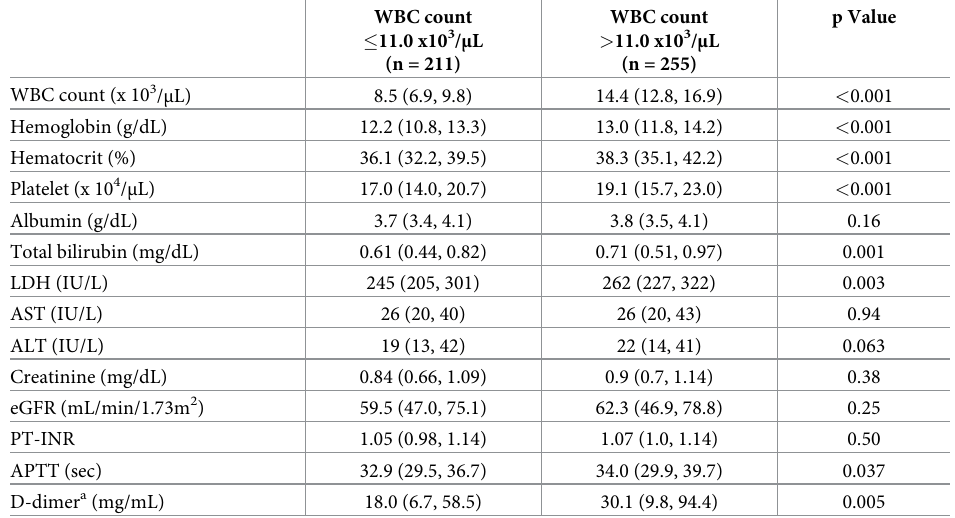
Table 2. Patients’ admission laboratory values, per white blood cell count ( � 11.0 x10 3 / μ L vs. > 11.0 x10 3 / μ L).